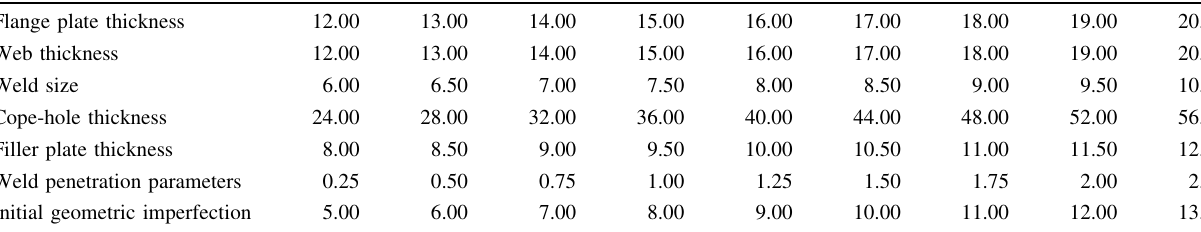
Table 2 Dimension of welded details used in parametric studies (in mm) Flange plate